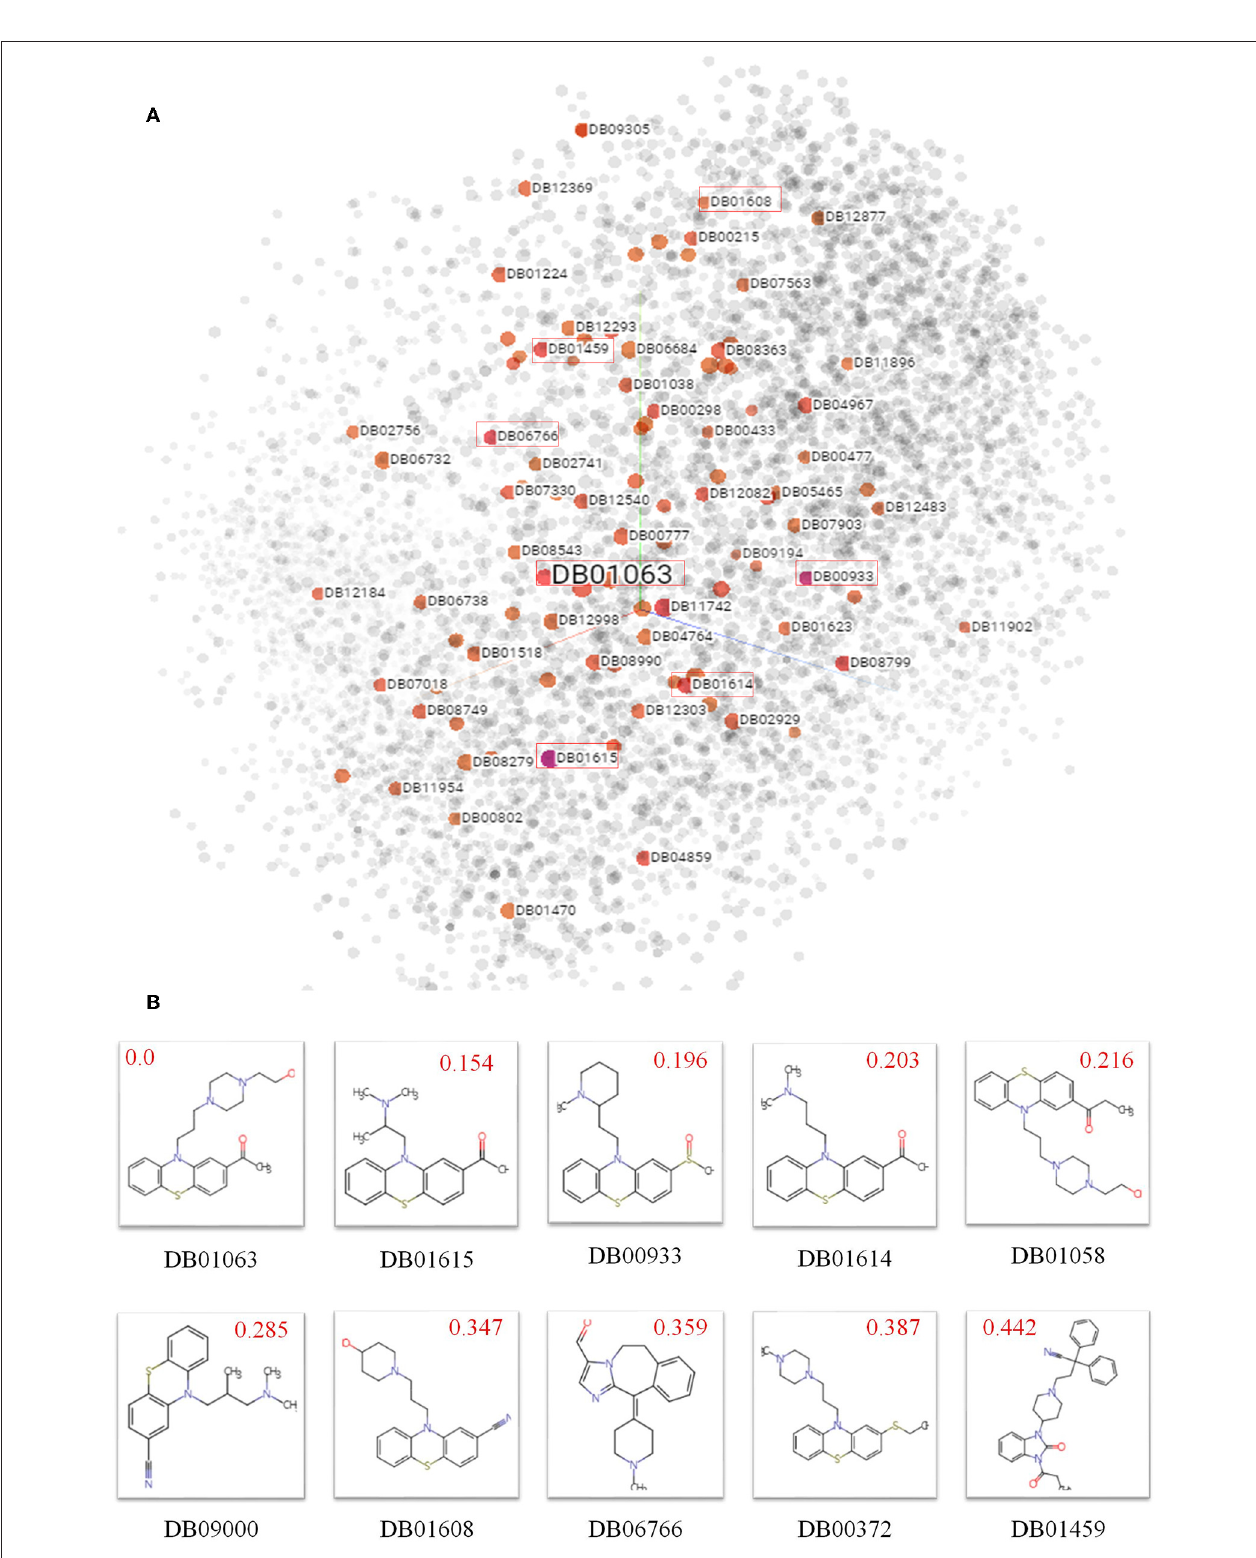
FIGURE 2 | Biochemical implications from SMILES2Vec features. (A) Visualizations of the SMILES2Vec vector space of drugs in DrugBank using t-SNE. (B) The top 10 drugs most similar to Acetophenazine (DrugBank ID: DB01063) according to their SMILES2Vec vectors. Red values show their cosine distances with Acetophenazine. The smaller the value, the more similar in the chemical structures.